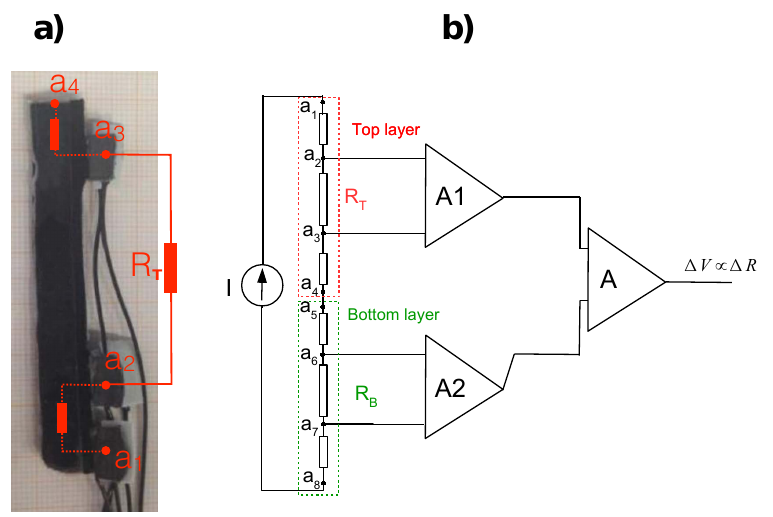
Figure 5. ( a ) A picture of the KPF goniometer showing the four pads for wiring connection; ( b ) diagram of the KPF goniometer acquisition